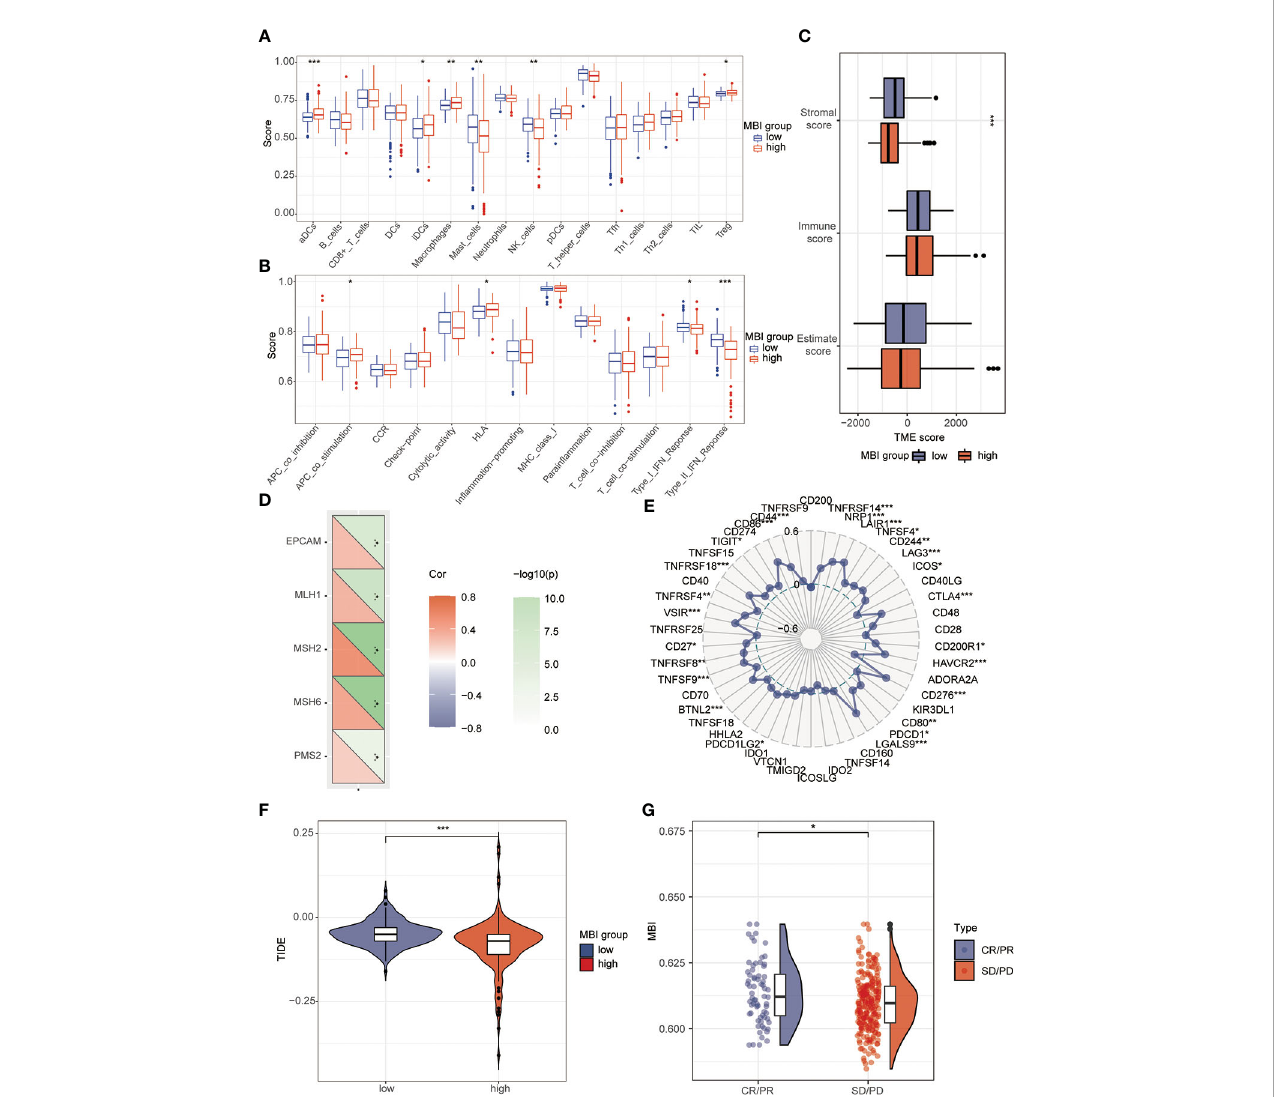
FIGURE 7 Analysis of immune cells, immune terminology and immunotherapy. (A) Immunoassay revealed the expression of aDCs, iDCs, Macrophages, Treg in the high MBI group. Mast_cells and NK_cell are mainly expressed in the low MBI group. (B) APC_co_stimulation and HLA are mainly expressed in the